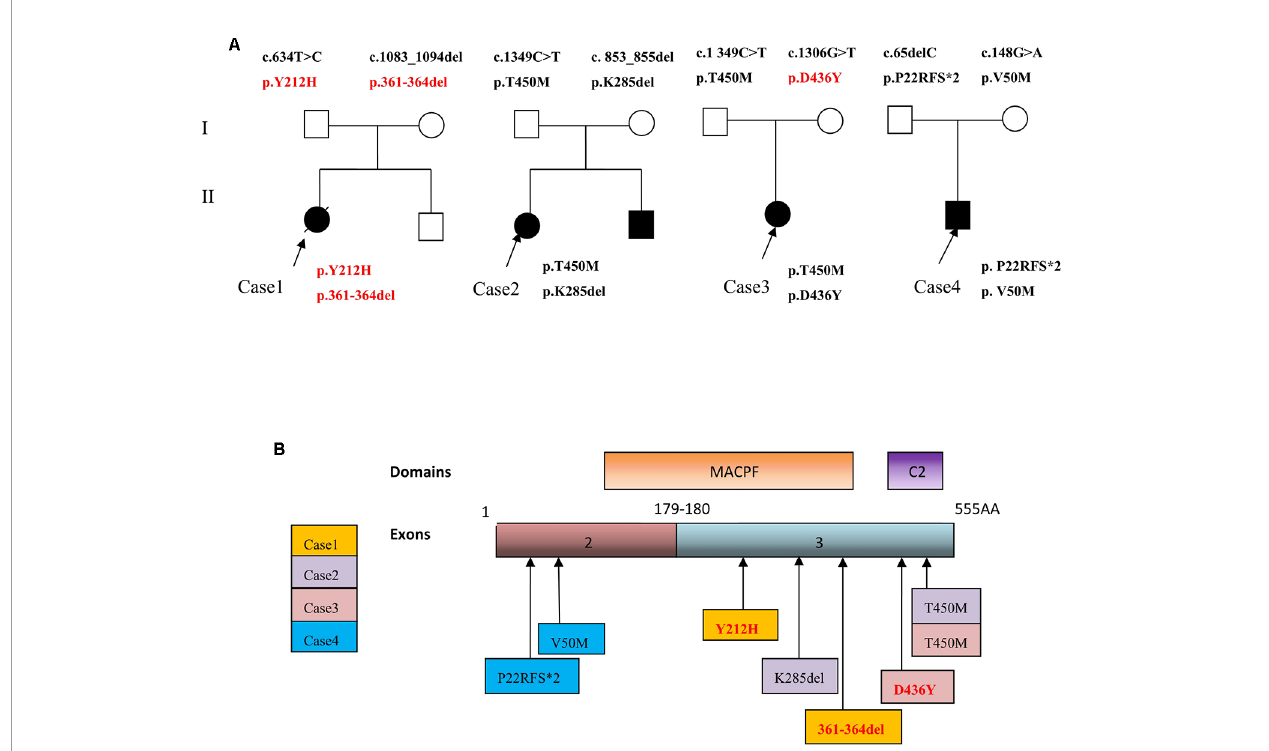
FIGURE 3 | (A) Family trees offour FHL2 patients with perforin gene mutations. (B) Schematic illustration showing mutation sites of the perforin gene in the FHL2